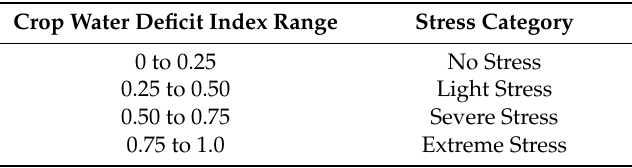
Table 3. Crop Water Deficit Index scale and